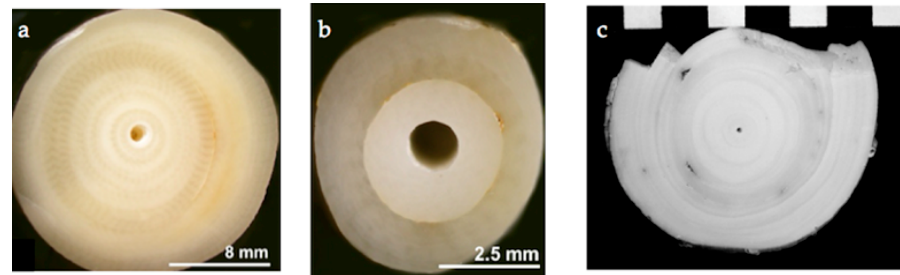
Figure 5. Samples measured in this study: ( a ) Jasus; ( b ) Terrasses; and ( c ) Valpareso.